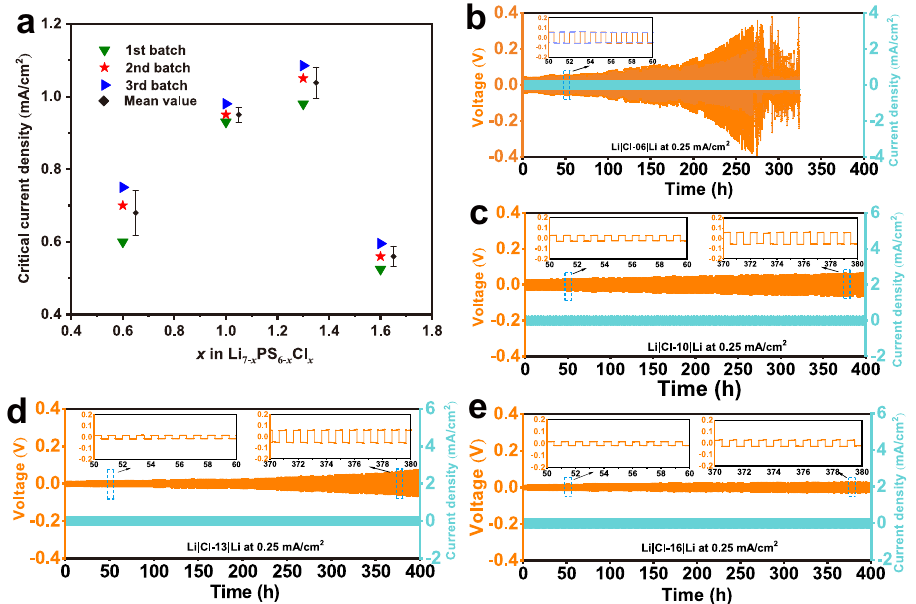
Fig. 3 Li dendrite suppression capability and long-term interface stability of Li|SE|Li using Li 7- x PS 6- x Cl x ( x = 0.6, 1.0, 1.3, and 1.6) SEs at 24 ± 4 °C. a Critical current density (CCD) for different argyrodite batches. Long-term Li plating/stripping cycling at 0.25 mA/cm 2 for Cl-06 ( b ), Cl-10 ( c ), Cl-13 ( d ), and Cl-16 ( e